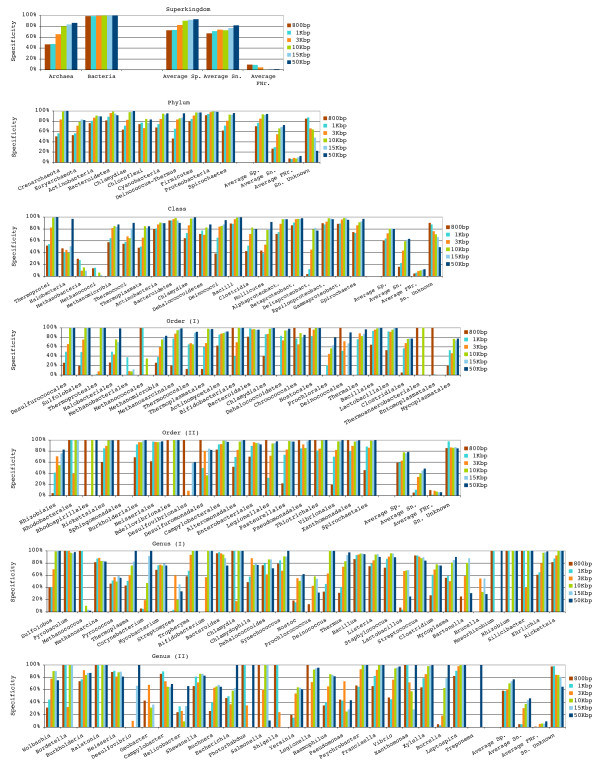
Classification accuracy achieved for genomic fragments of different lengths. Bars depict detailed specificity and average values for specificity (Sp.), sensitivity (Sn.) and false negative rate (FNr.) for each fragment length on different taxonomic ranks. Each color represents a genomic fragment length.